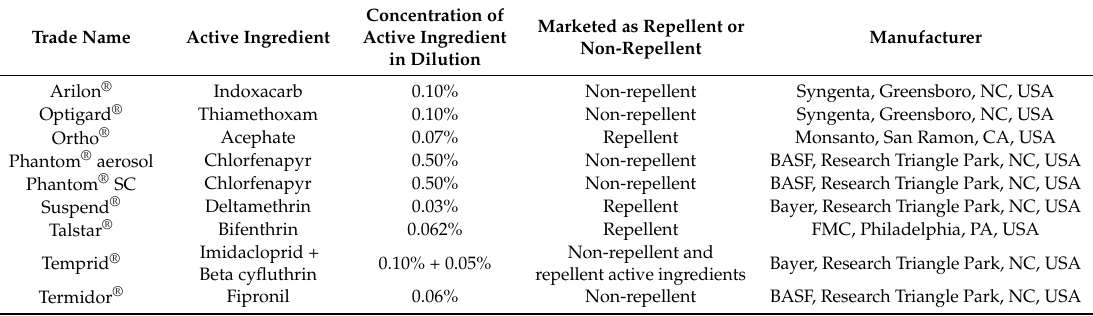
Table 1. Nine commercially available contact insecticides tested for repellency and efficacy against Nylanderia fulva in laboratory